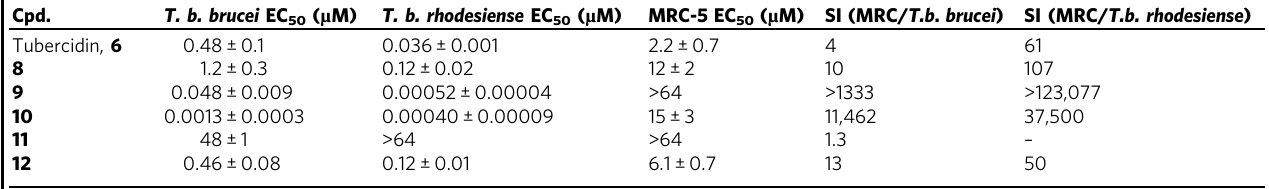
Table 1 In vitro drug sensitivity of 7-deazapurine nucleoside analogues. Cpd.